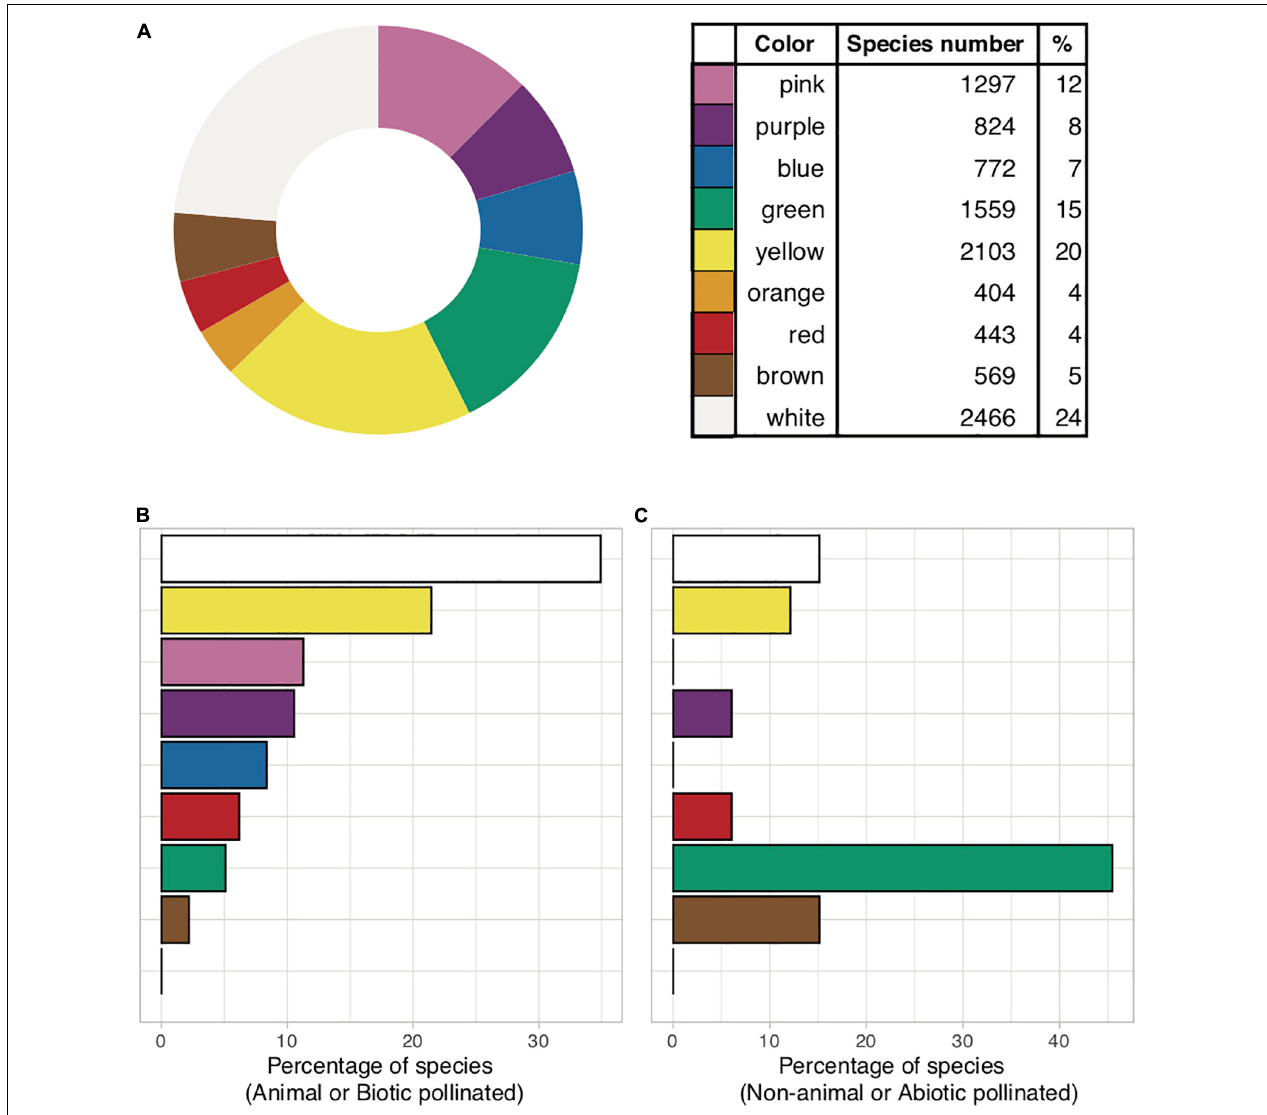
FIGURE 2 | (A) Global flower color frequency based on human visual perception ( n = 10,437 species; data source: Kattge et al., 2020, https://www.try-db.org/TryWeb/). (B) Flower color frequency in animal pollinated species ( n = 275) where less than 10% are blue. (C) Non-animal pollinated species ( n = 33), where blue does not occur. All wind-pollinated angiosperms are secondarily wind-pollinated and thus the color of these flowers might be relicts from a previous animal pollinated period. (B,C) are limited to European data only. R code available in Supplementary Appendix 1